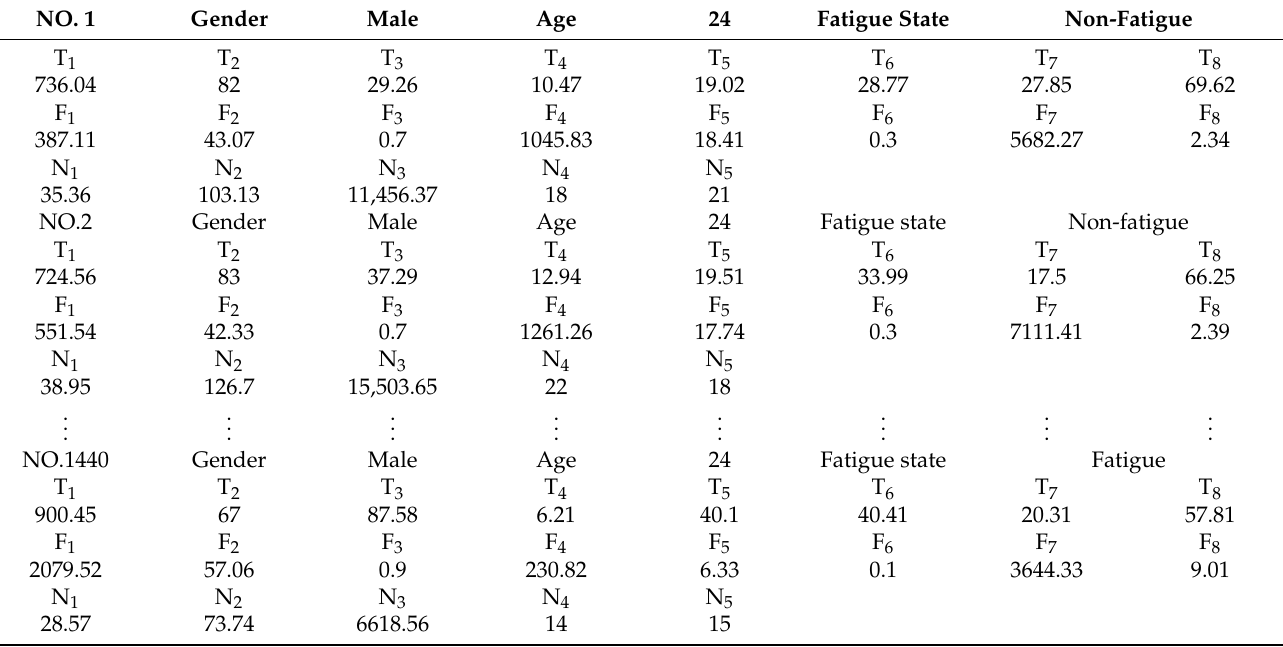
Table 6. Some experimental sample